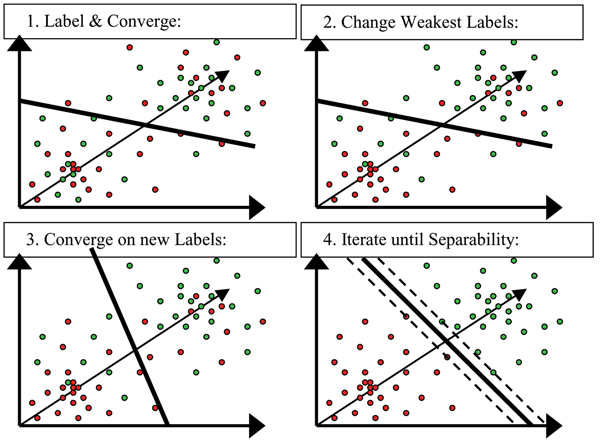
Shown is the schematic for an "external" SVM clustering algorithm.